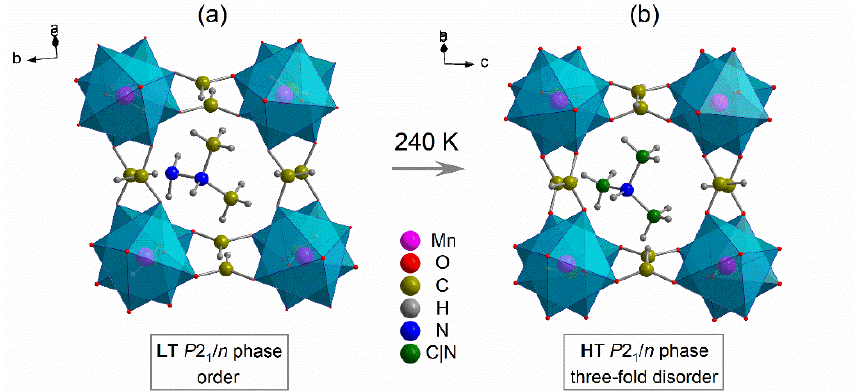
Figure 1. The crystal structure of the LT ( a ) and HT ( b ) phase of [DMHy]Mn(HCOO) 3.